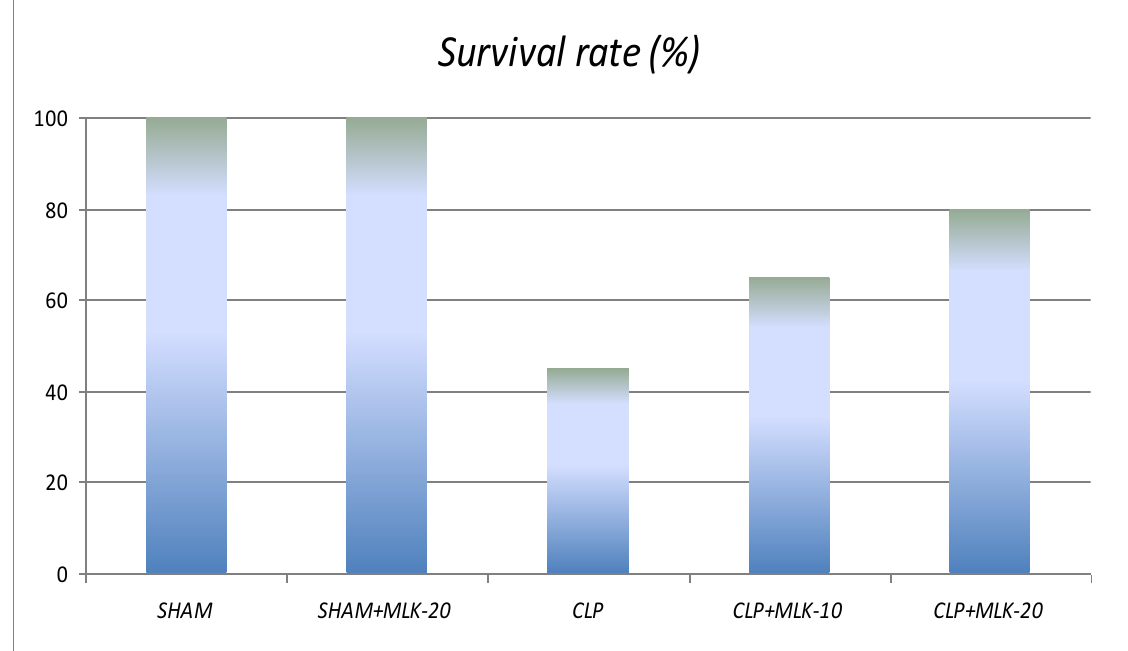
FIGURE 1. Survival rates (%) of the experimental groups. CLP: cecal ligation and puncture applied; MLK: montelukast treated; SHAM: sham